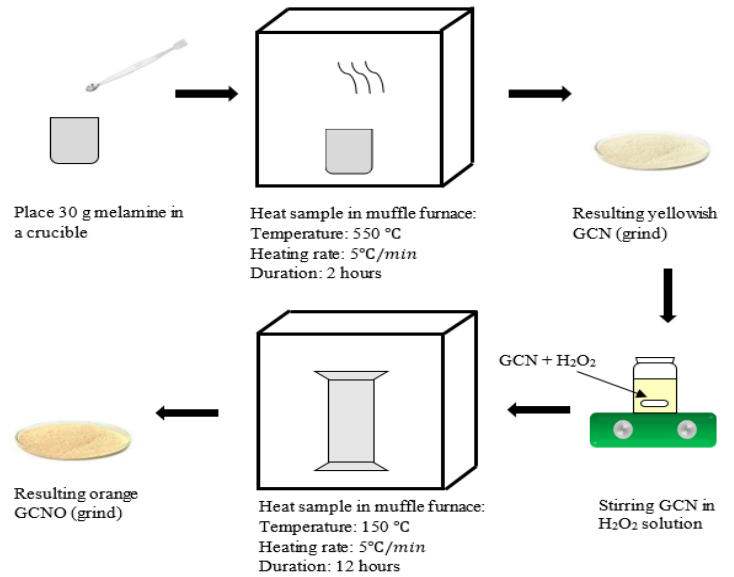
Figure 1. Synthesis procedure of the oxygen doped GCN (graphitic carbon nitride).